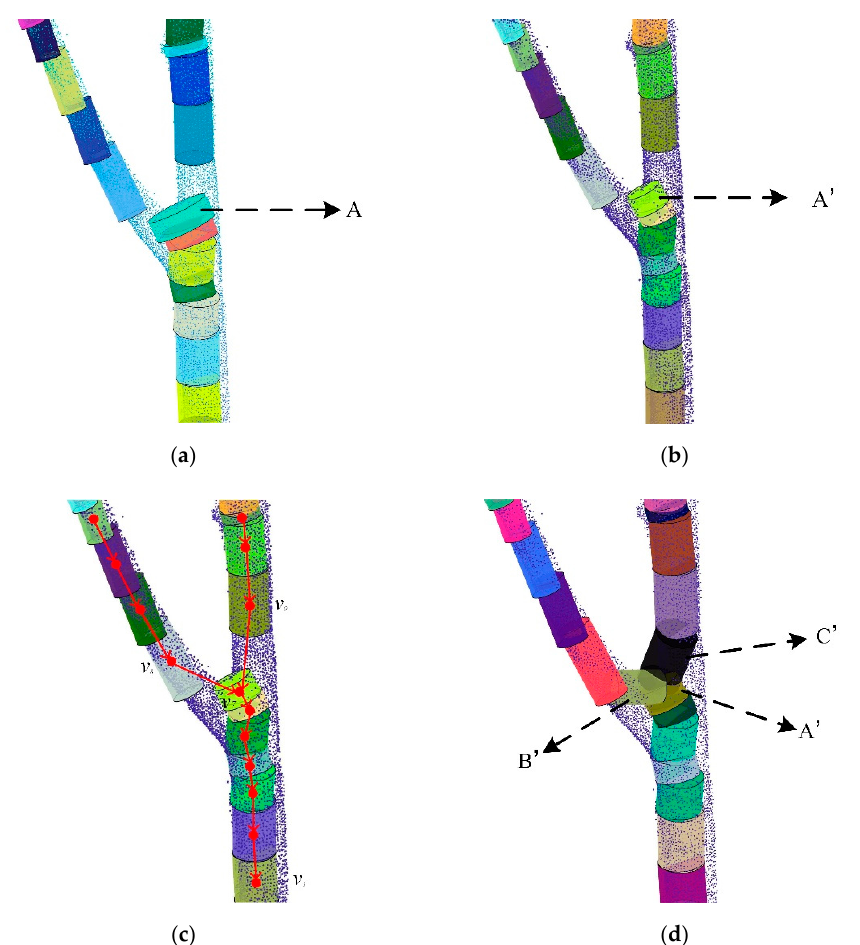
Figure 11. Self-revision of branch crosses. ( a ) Local abnormal cylinder; ( b ) cylinder after optimization; ( c ) shortest path analysis based on the constructed graph structure; ( d ) branch crosses after self-revision. In ( a ), ‘A’ represent the abnormal cylinder. In ( b ), ‘A’’ represents the optimized cylinder. In ( d ), ‘B’ and ‘C’ represent the cylinders filled the gap.